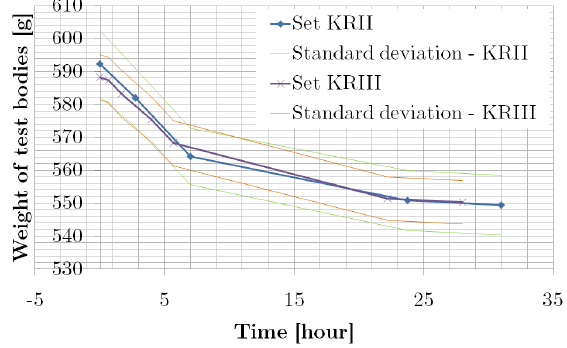
Figure 5. Time course of the test bodies weight after the first 30 hours from manufacture.